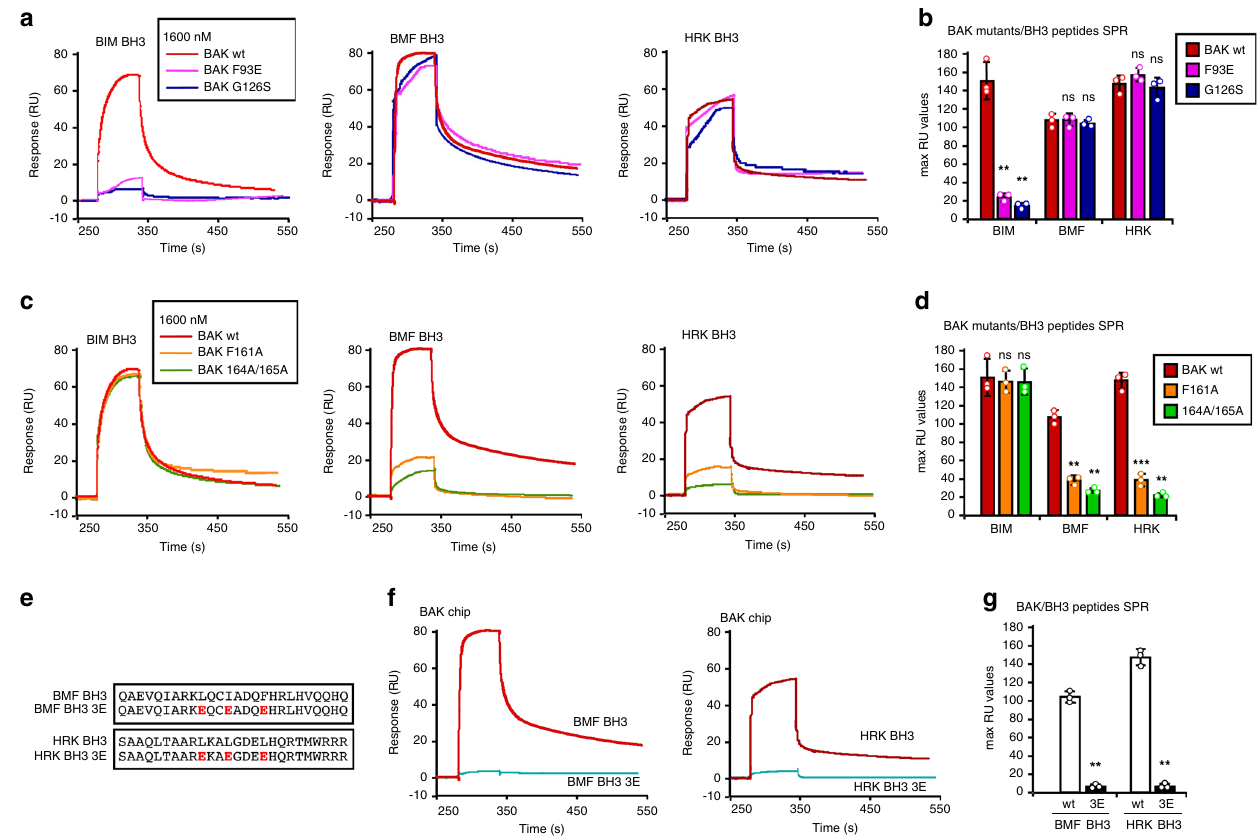
Fig. 6 BMF and HRK bind the BAK α 4/ α 6/ α 7 groove. a SPR (relative units (RU)) as a function of time observed when similar levels (about 4000 RU) of WT BAK Δ TM or BAK Δ TM with mutations in the canonical BH3-binding groove were immobilized and exposed to 1600 nM BIM BH3 (left), BMF BH3 (middle), or HRK BH3 (right). b Maximum RU values obtained from binding isotherms using a series of concentrations of the corresponding peptides in a , and p = 0.007, 0.008 for BIM BH3; 1.0, 0.48 for BMF BH3; and 0.06, 0.26 for HRK BH3 when maximum RU values of binding to BAK F93E or G126S, respectively, were compared with WT BAK. c SPR as a function of time observed when similar levels (~4000 RU) of WT BAK Δ TM or the indicated BAK Δ TM α 4/ α 6/ α 7 groove mutant were immobilized and exposed to 1600 nM BIM BH3 (left), BMF BH3 (middle), or HRK BH3 (right). d Maximum RU values obtained after exposure of the indicated BAK species to a series of concentrations of the corresponding peptides in c . p = 0.52, 0.32 for BIM BH3; 0.004, 0.001 for BMF BH3; 0.0003, 0.001 for HRK BH3 when maximum RU values of binding to BAK F161A, or 164/165A, respectively, were compared to WT BAK. e Sequences of 3E BMF and HRK BH3 peptides bearing alterations in the indicated hydrophobic residues. f SPR observed when immobilized BAK Δ TM was exposed to 1600 nM BMF BH3 or its mutant (left) and HRK BH3 or its mutant (right). g Maximum RU values obtained after exposure of BAK Δ TM to a series of concentrations of the peptides in f . p = 0.001 and 0.001 for BMF and HRK BH3, respectively, when maximum RU values observed with the 3E mutants were compared with corresponding WT BH3 peptides. Error bars in b , d , g : mean ± S.D. of three independent experiments. ns, p > 0.05; **, p < 0.01; *** p < 0.001; two-tailed paired t test for maximum RU values of mutants vs WT. Source data are provided as a source data fi transiently expressed BH3-only proteins fused to EGFP (Fig. 7b – d). Apoptosis induction by EGFP-BIM (Supplementary Fig. 8a) or EGFP-PUMA (Fig. 7c) was not inhibited in cells expressing BAK F161A but was inhibited by the BAK G126S mutation even in the presence of the reciprocal N86G mutation (Fig. 7d) that allows BAK oligomerization 17,38 . In contrast, cytotoxicity of EGFP-BMF or EGFP-HRK was markedly diminished by the BAK F161A mutation (Supplementary Fig. 8a and Fig. 7c), re fl ecting inability of EGFP-BMF or HRK to induce activation of BAK F161A (Fig. 7e), but was relatively unaffected by the BAK G126S/N86G mutation (Fig. 7d and Supplementary Fig. 8b).